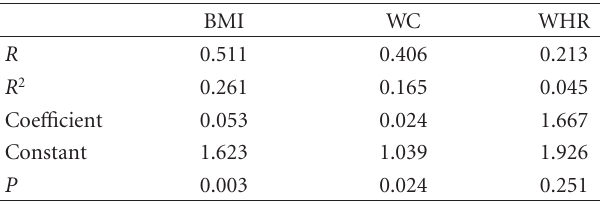
Table 3: Regression analysis of number of the metabolic syndrome factors versus BMI, WC, and WHR.